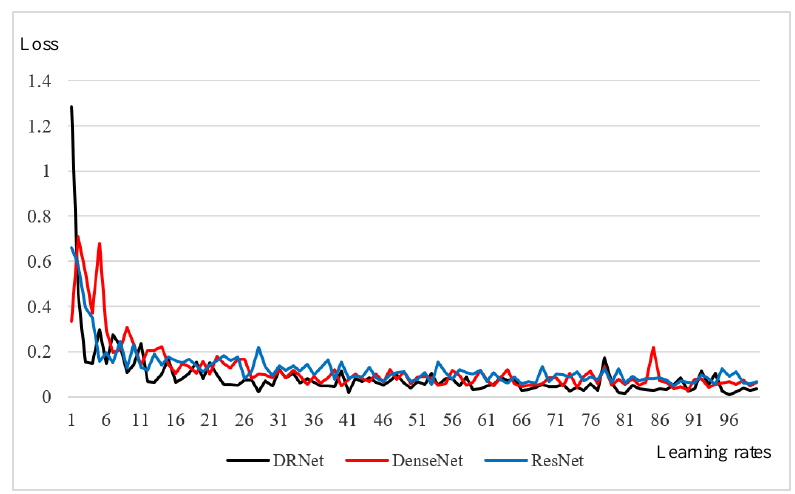
Figure 7. Loss curve of the networks.